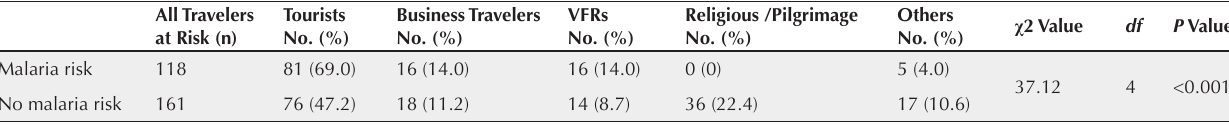
Table 4. Malaria Risk and Malaria Prophylaxis According to Reason of Travel